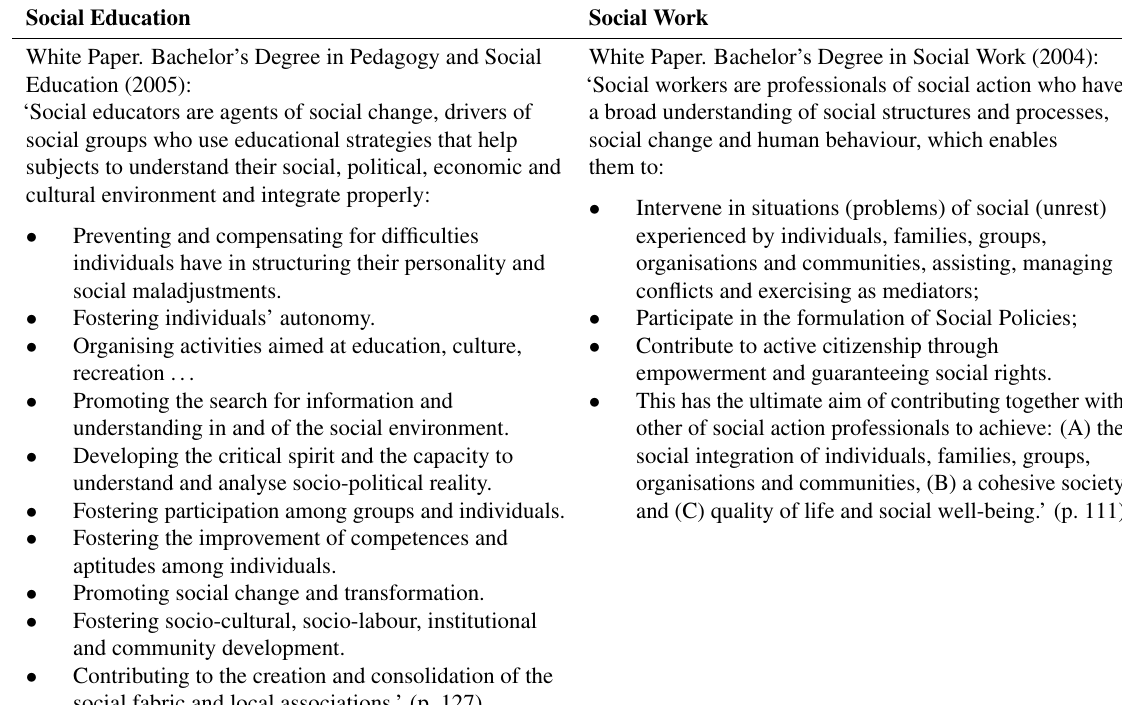
Table 3. Comparison of the professional profiles of social educator and social worker based on the definitions provided by the respective White Papers and the respective General Associations (Source: Author,